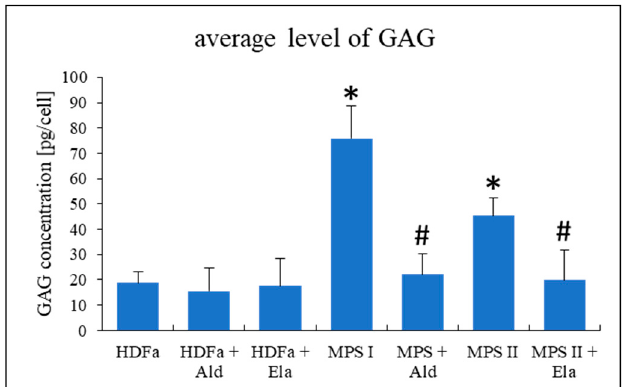
Figure 10. Levels of GAGs in HDFa (control) cells and MPS I and MPS II fibroblasts with and without treatment with 0.58 mg/L α -L-iduronidase (Aldurazyme, Ald) or 0.5 mg/L iduronate sulfatase (Elaprase, Ela) for 24 h. Mean values ± SD are presented, with asterisks and hashtags representing statistically significant ( p < 0.05) differences relative to the HDFa control and untreated MPS, respectively.